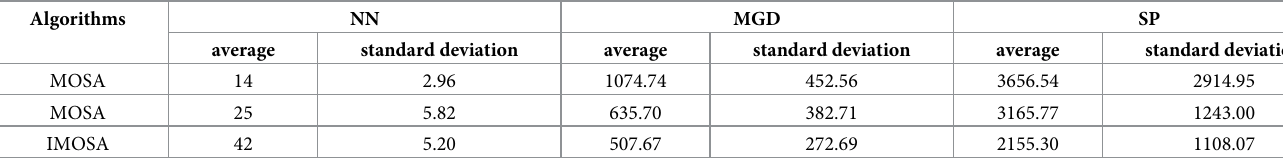
Table 2. Comparisons of performance indicators of two